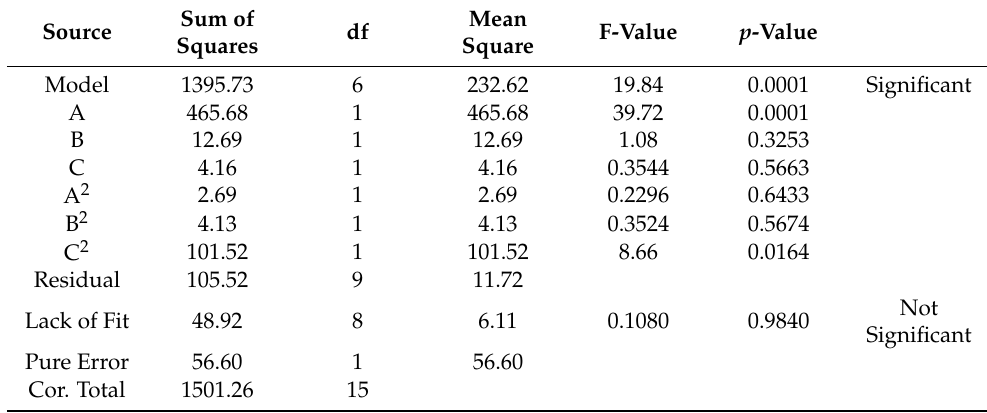
Table 3. Results of ANOVA analysis of the regression model. Parameters with p -value ≤ 0.001 are considered